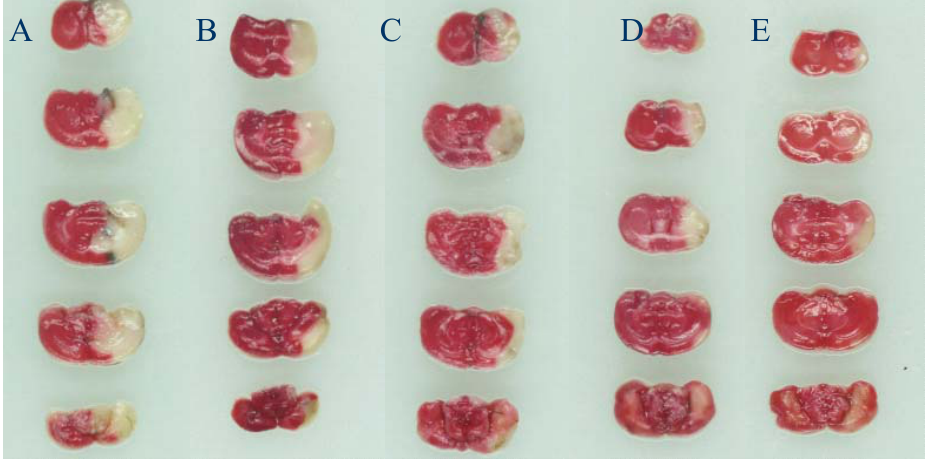
Figure 1. Representative coronal brain sections (1.5 mm thick) after 22 h of reperfusion showing infarction. ( A ) Vehicle group; ( B ) Lavender oil-treated group (50 mg/kg); ( C ) Lavender oil-treated group (100 mg/kg); ( D ) Lavender oil-treated group (200 mg/kg); ( E ) Edaravone-treated group (3 mg/kg).